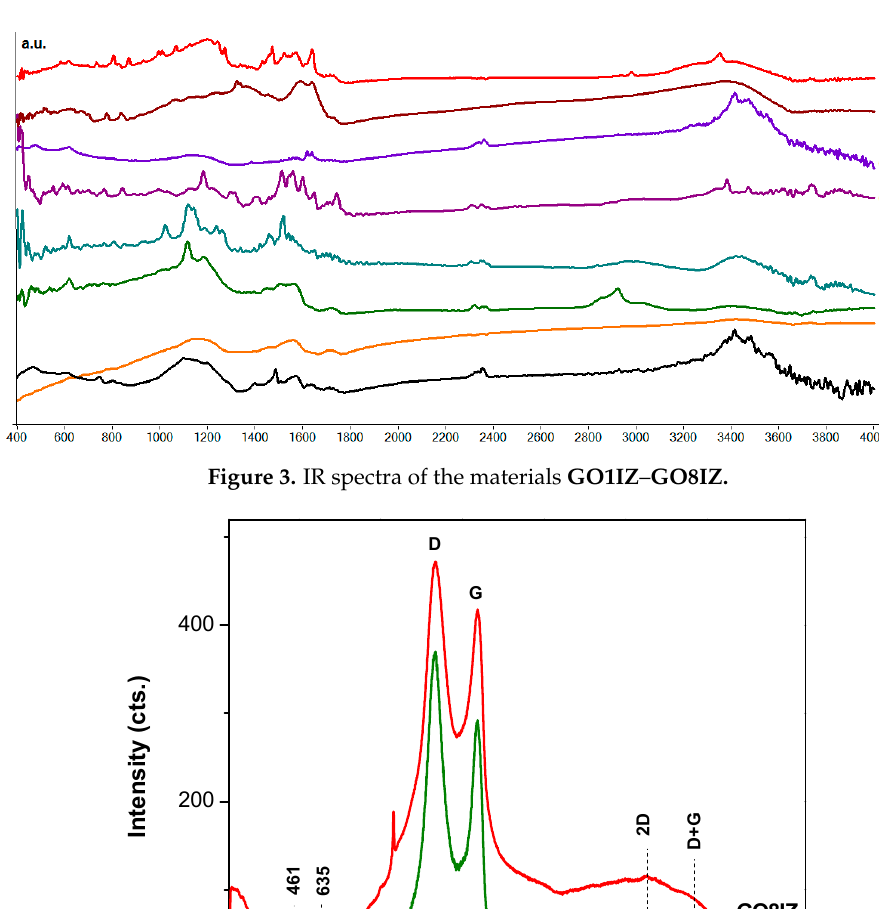
Figure 3. IR spectra of the materials GO1IZ-GO8IZ.